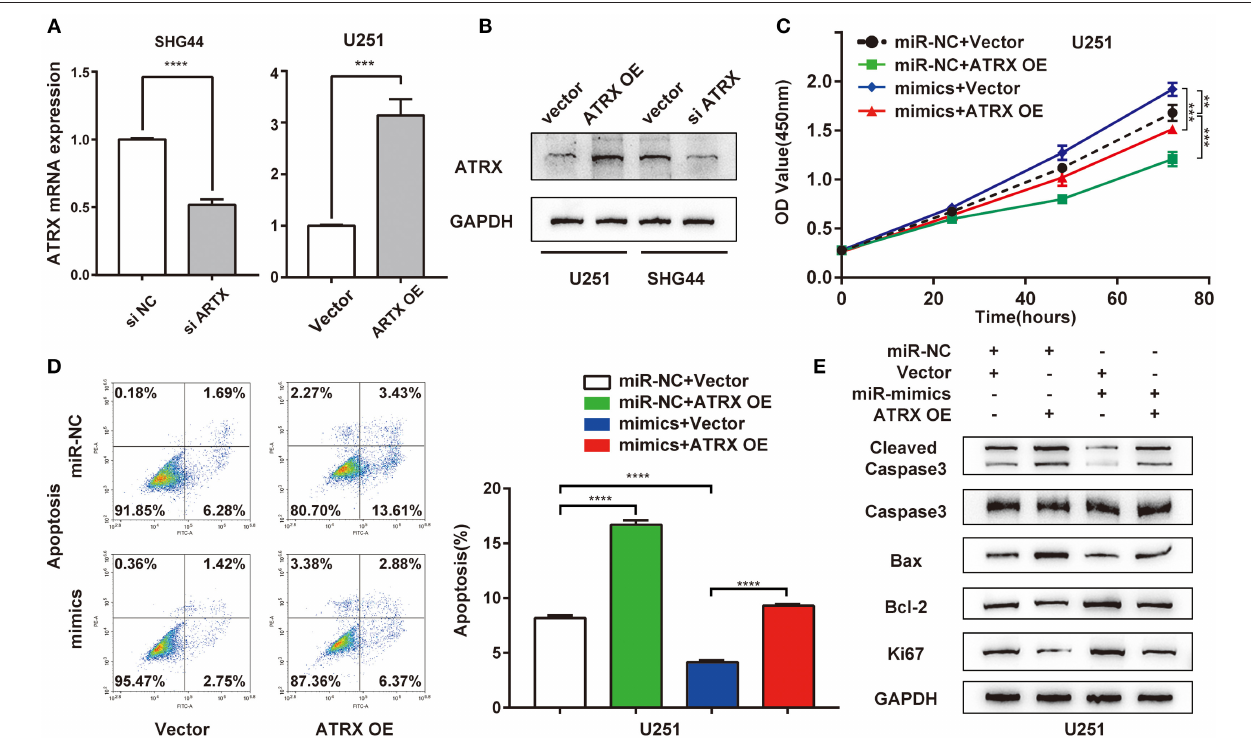
FIGURE 4 | ATRX overexpression reverses the suppressive effects of miR-1269a on proliferation and apoptosis in glioma cell lines. (A,B) Transfection efficiency of ATRX overexpression or knockdown in U251 or SHG44 was determined by qPCR and Western blot. (C) Cell proliferation was determined via the CCK8 assay. (D) Cell apoptosis was determined via the flow cytometry assay. (E) The protein expression levels of proliferation (Ki67) and apoptosis (cleaved caspase 3, caspase 3, Bax, and Bcl-2) were detected using Western blot. *** P < 0.001, and **** P <